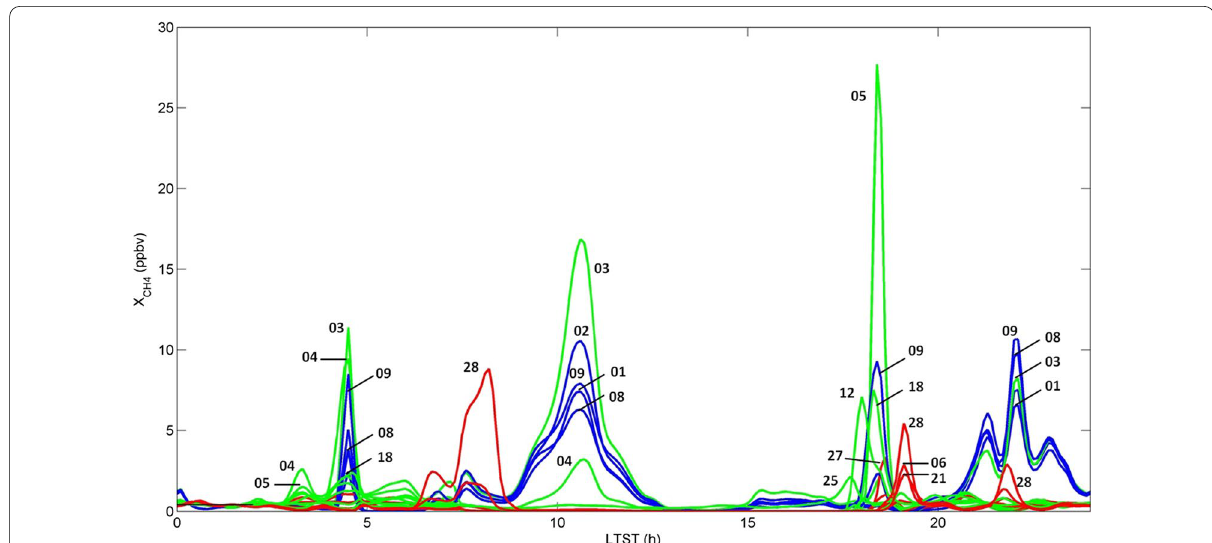
Fig. 8 Simulated methane spikes during the diurnal cycle at MSL’s general location, in the first prognosed layer (~ 10 m), for the south and southeast emission sources (see text). Numbers around the spikes are referred to the labels established for each emission location as presented in Fig. 6. Almost every source location in the vicinity of MSL produces methane spikes at MSL’s general location. Locations within ф R 2 are represented in green color. Western locations ( ф R 1 )are represented in blue color and eastern ones ( ф R 3 )in red